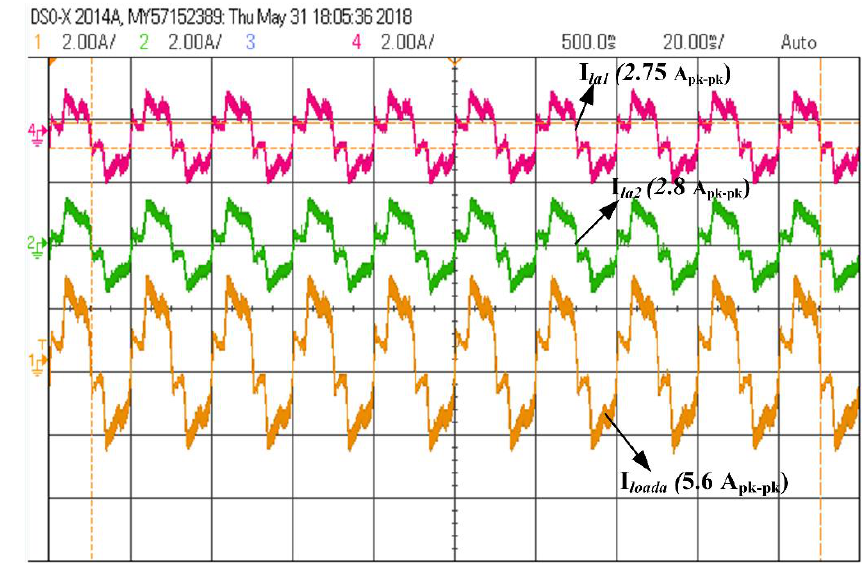
Figure 27. Output currents of Inverter-1, Inverter-2 and Load.